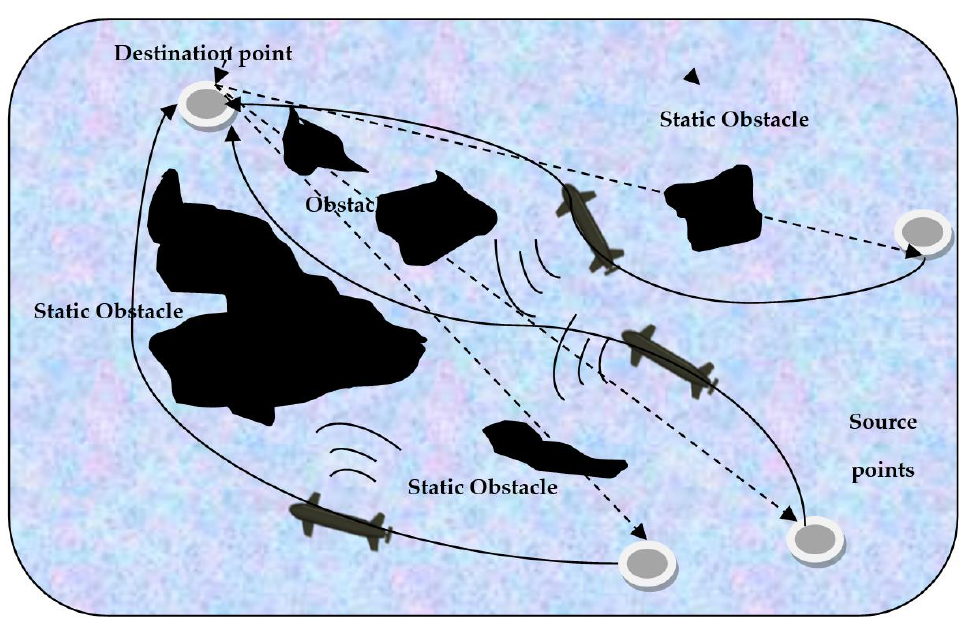
Figure 2. Hybrid path planning of AUVs using HGWO.